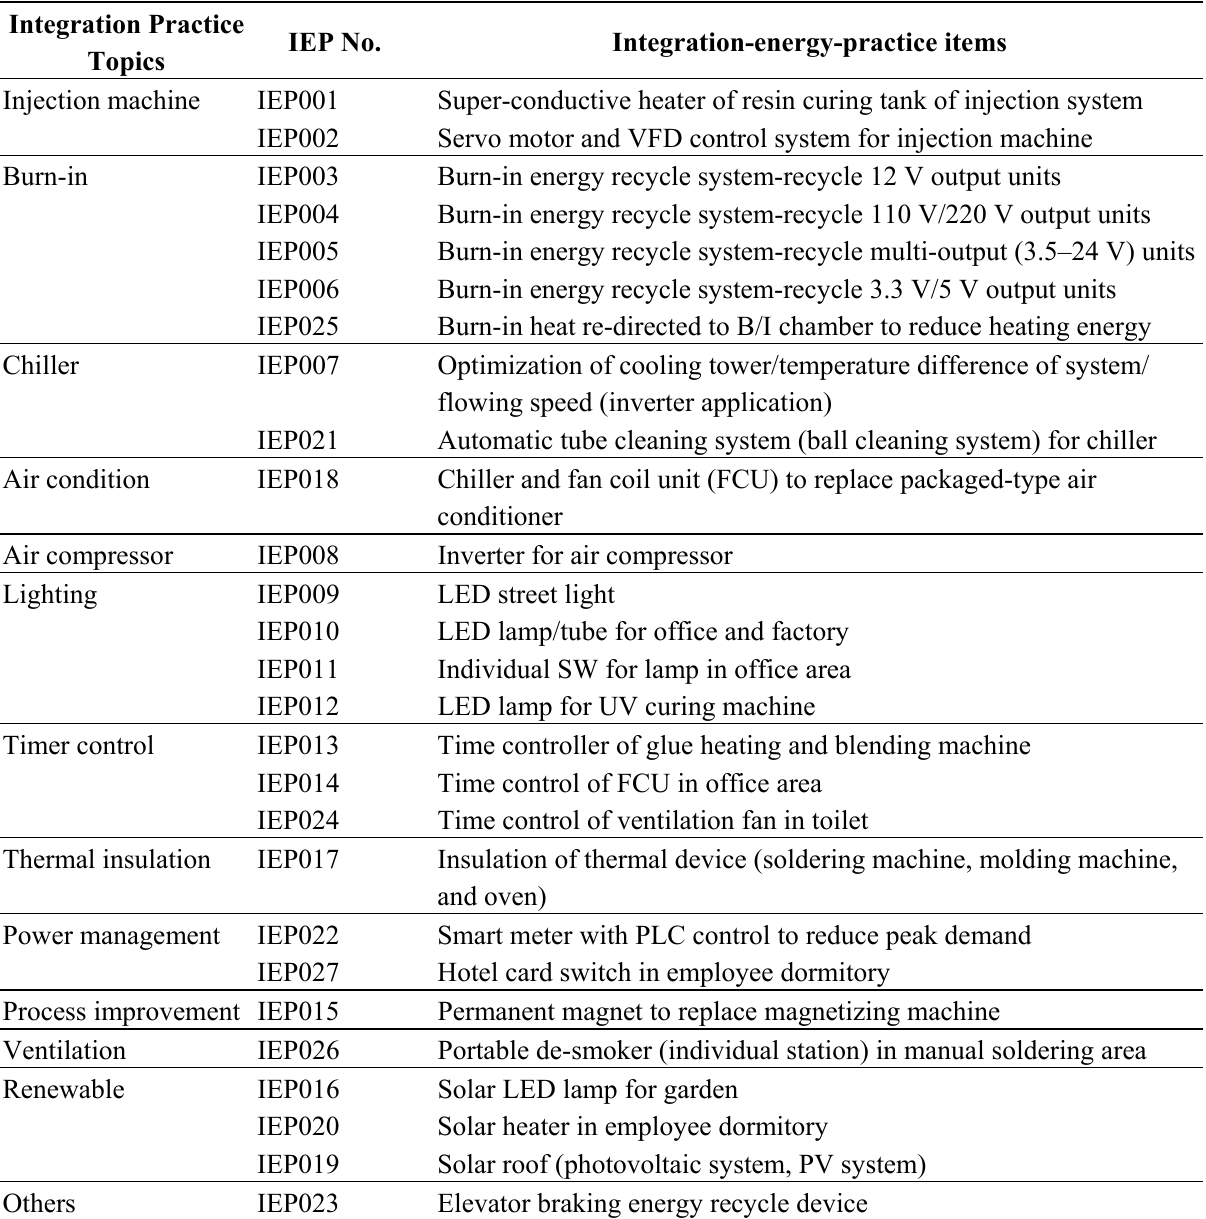
Table 1. Integration-energy-practice (IEP) topics and